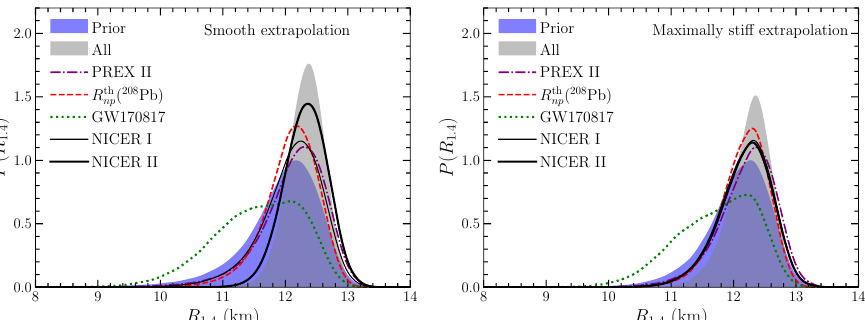
Figure 4. The R 1.4 probability densities (priors, individual posteriors, and combined posteriors) from the smooth high-density extrapolation ( left ) and the maximally-stiff high-density extrapolation ( right ) energy density functionals.